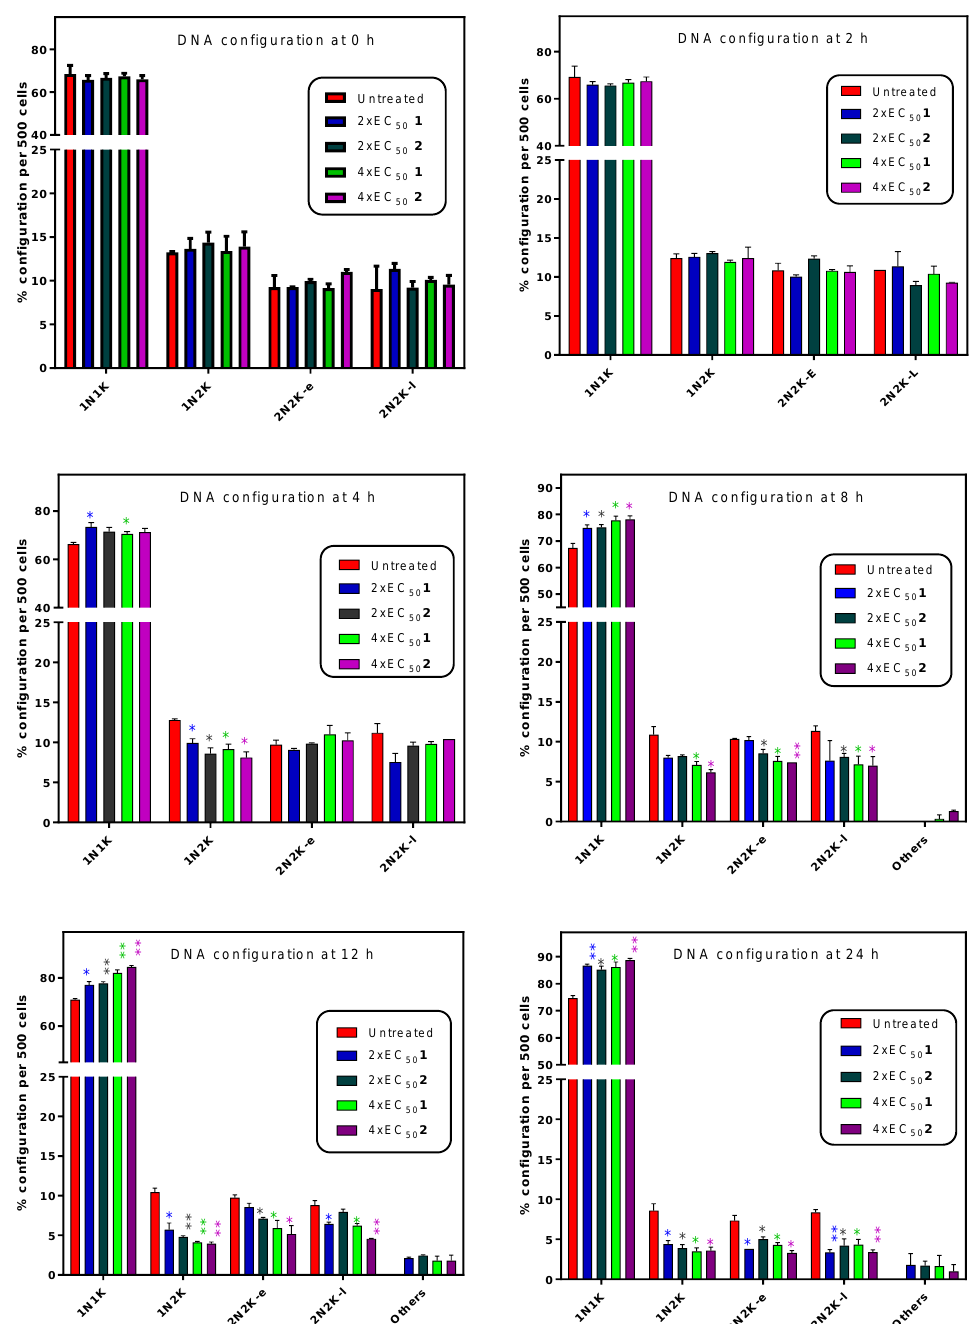
Figure 5. Cell configuration in DAPI stained cell populations. Samples were taken at the indicated times from cultures incubated with or without test compounds 1 and 2 , stained with the nucleic acid dye DAPI and observed by fluorescence microscopy. For each sample, 500 cells were scored in categories for the number of kinetoplasts (K) and nuclei (N), with the sub-classification early (e) indicating the absence of an ingression furrow for cell division, and late (l) indication a clear presence of an ingression furrow. Each bar represents the average and SD of two independent experiments. In each category, the treated samples were statistically compared to the treated sample by unpaired t -test. * p < 0.05; ** p < 0.01. For the category ‘others’ no statistical comparison could be performed as no ‘others’ were observed in the control culture. Observation and scoring of cells were done using a Zeiss Axioskop fluorescence microscope.